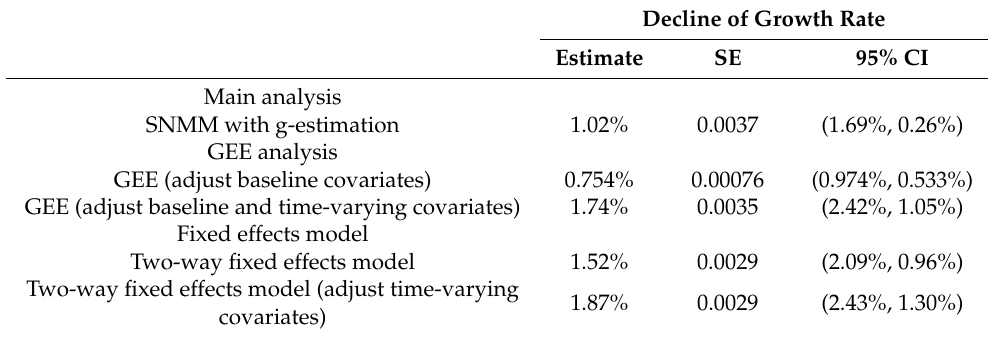
Table 2. Impact of the COVD-19 vaccine program on the weekly growth rate of new COVID-19